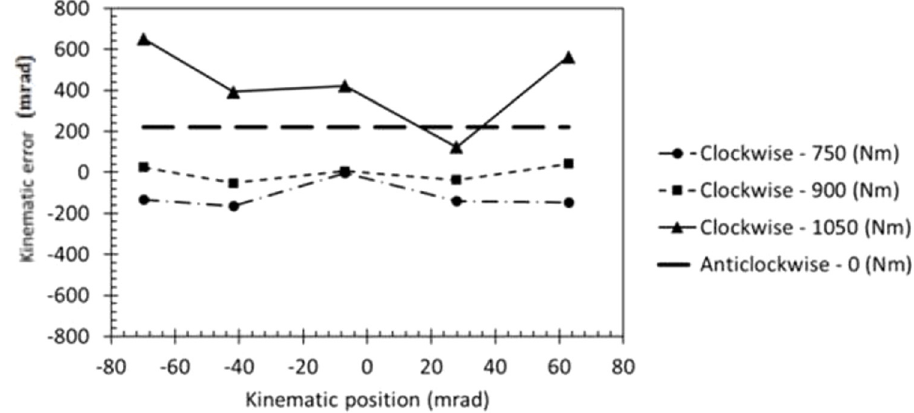
Fig. 13. Comparison between the maximum clockwise kinematic errors (corresponding to the con fi guration of deformed worm against deformed wheel, computed at different torques), with the minimum anti-clockwise kinematic error (corresponding to the con fi guration of non-deformed worm against non-deformed wheel, computed at zero